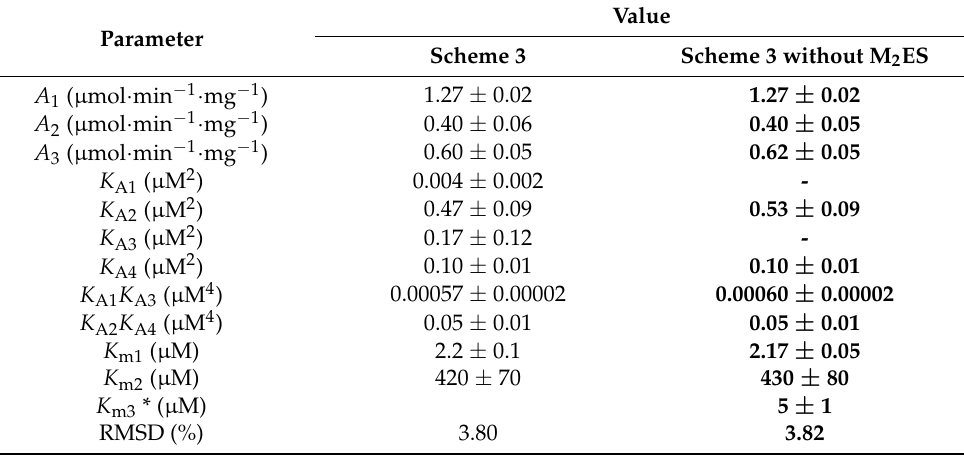
Table 2. Kinetic parameters for Dh-mPPase activation by Mg 2+ as calculated from the data in Figure 5 according to Scheme 3 and its shorter